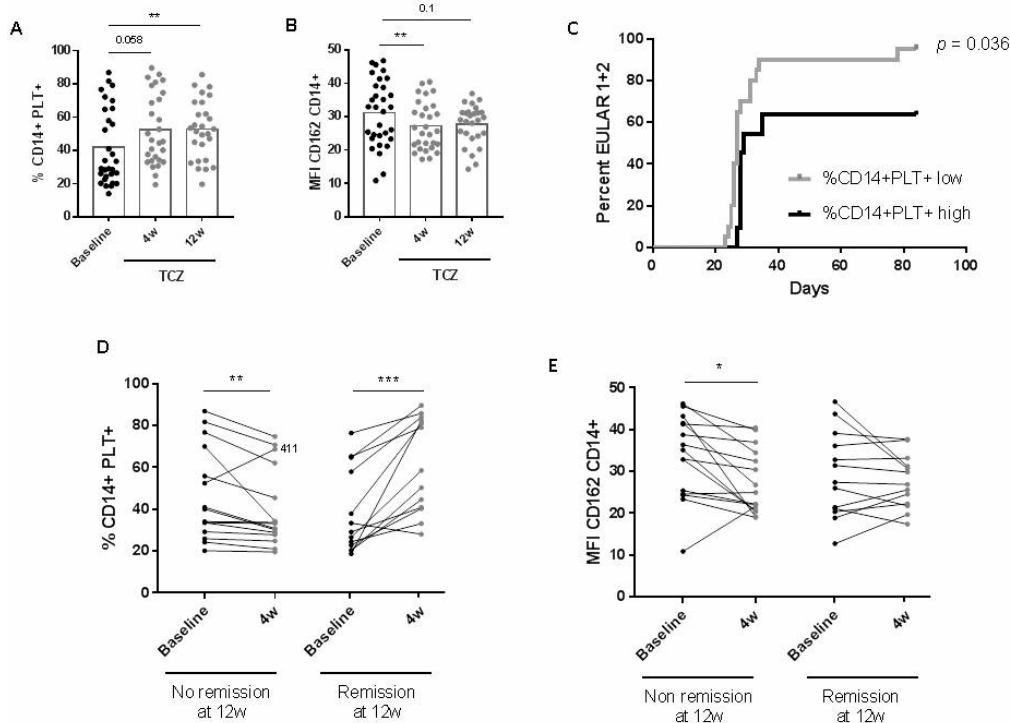
Figure 3. Changes in monocytes with bound platelets and CD162 expression after tocilizumab treatment and association with clinical response in rheumatoid arthritis (RA) patients. ( A ) Per- centage of monocytes with bound platelets (CD14+PLT+) and ( B ) CD162 expression on monocytes before (Baseline) and four weeks (4 w) and twelve weeks (12 w) after tocilizumab (TCZ) treatment. ( C ) Kaplan-Meier curve for EULAR response. Percentage of patients with low or high %CD14+PLT+ achieving 1 (moderate) or 2 (good) EULAR response (days). ( D ) Changes in the percentage of CD14+PLT+ and ( E ) CD162 expression after 4 w of TCZ treatment in rheumatoid arthritis patients with no remission or remission at 12 w ( left ). Black circles represent RA patients before TCZ treatment, and grey circles RA patients after TCZ treatment. Statistical analysis was performed using Wilcoxon test for comparisons between baseline and 4 w or 12 w after TCZ treatment and log-rank Mantel–Cox test for the analysis of EULAR response during follow-up. * p < 0.05, ** p < 0.01, *** p < 0.001.